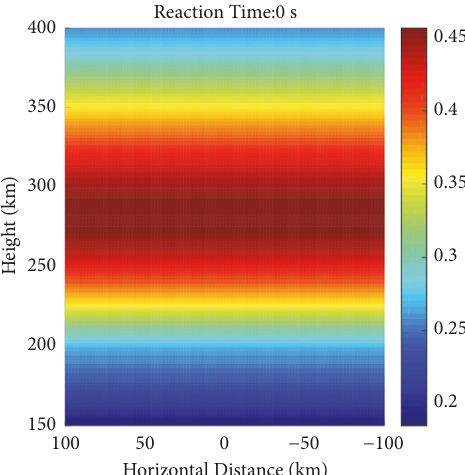
Figure 5: Background ionospheric electron concentration profile in the Nanjing area in summer.